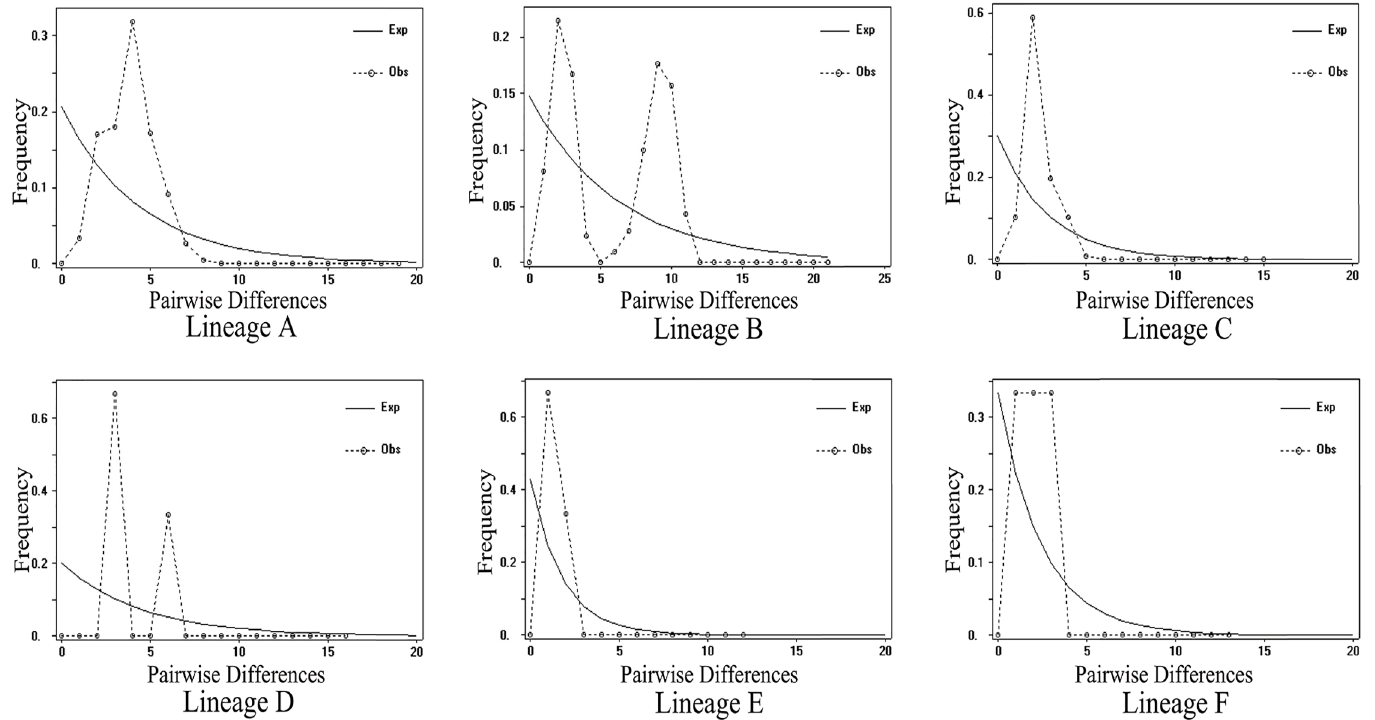
Fig 4. Mismatch distributions for six major lineages of O . schmackeri species complex. The dotted and thin lines represent the observed and expected mismatch distributions of a stationary population,